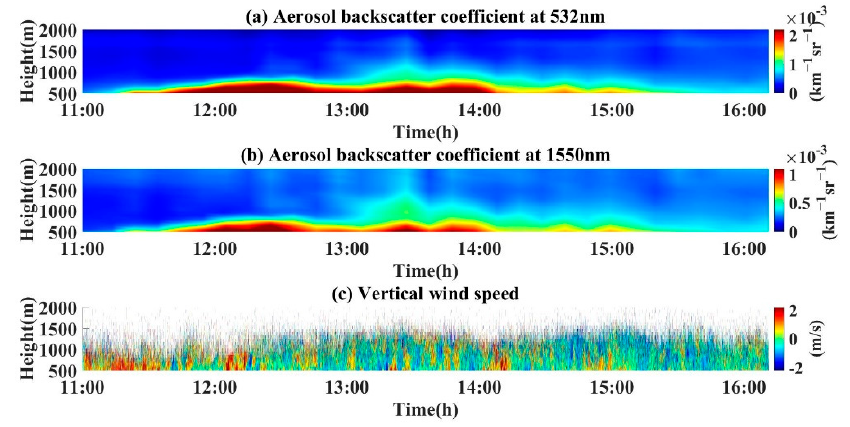
Figure 6. The time–space diagram of joint measurements results on 23 November 2021. ( a ) Aerosol backscatter coefficient at 532 nm in 10 min and 2.5 m resolution of Mie-scattering aerosol lidar, ( b ) aerosol backscatter coefficient at 1550 nm in 10 min and 60 m resolution of CDL, and ( c ) vertical wind speed in 1 s and 60 m resolution of CDL.